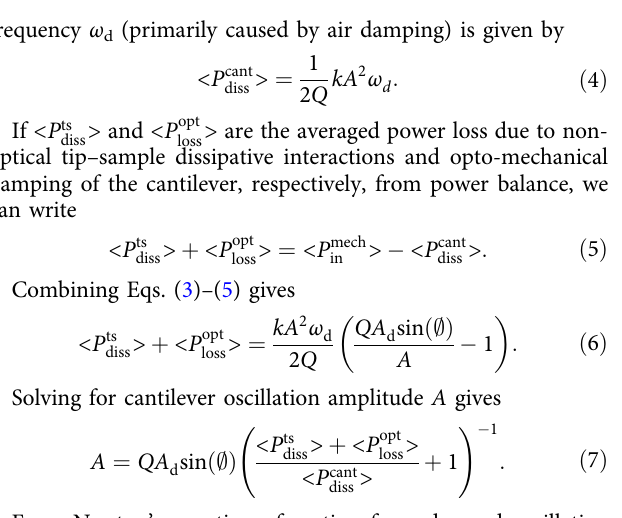
Fig. 5 Opto-mechanical damping. a , b are phase and amplitude of high Q (red) and low Q (black) harmonic oscillator. Change in the phase ( φ 2 ) and amplitude ( A 2 ) of the second mechanical mode (blue line) across PMMA absorption band (orange line) centered at 1733 cm − 1 for right excitation ( c , d ) and left excitation ( e , f ). Sample is 60-nm-thick PMMA on glass. The phase measurements were conducted using standard PiFM mixing mode, while amplitude measurements were conducted with the feedback loop open and the wavenumber scanned rapidly through resonance as explained in the